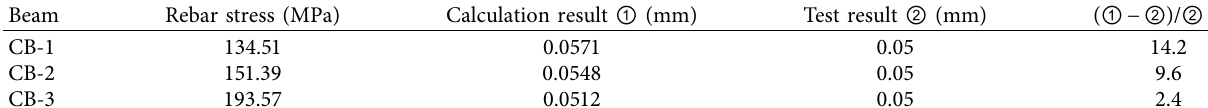
Table 7: Calculation of the critical crack width for the test beams.